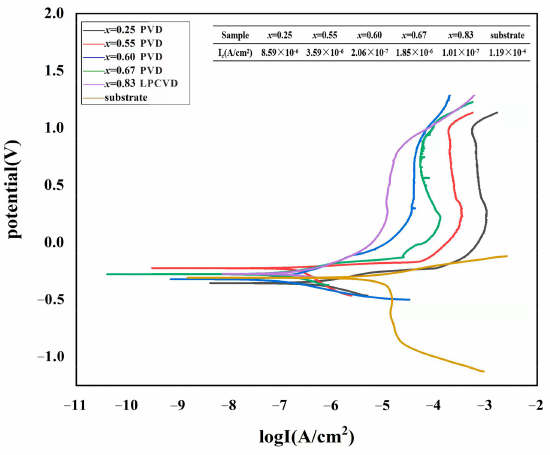
Figure 3. Potentiodynamic polarization curves of the Ti 1 − x Al x N coatings and